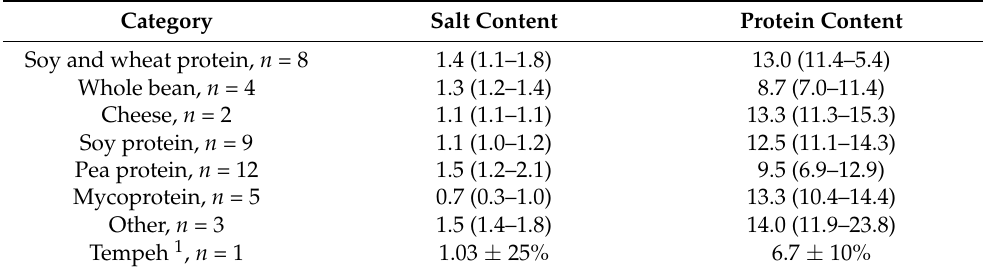
Table 4. Salt content and protein content separated and analyzed according to protein source. Data are shown as median value (25th percentile–75th percentile) presented as g/100 g product n = number of samples. 1 Data on tempeh are presented as average ± measurement uncertainty as reported by Eurofins analytical